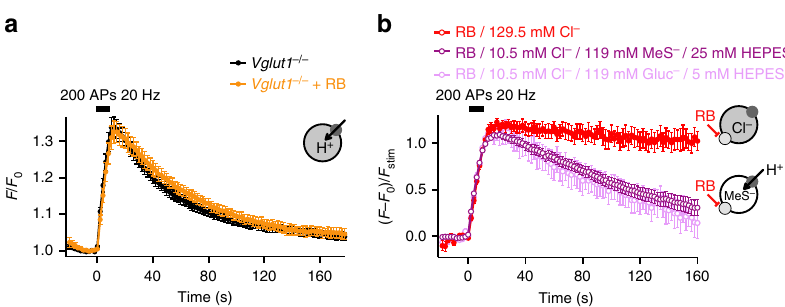
Fig. 2 VGLUT and V-ATPase are electrically coupled. a SpH fl uorescence time courses of glutamatergic boutons lacking VGLUT1 with ( n = 11) or without ( n = 22) RB. b SpH fl uorescence time courses upon stimulation (200 APs, 20 Hz) with RB and either normal Cl − concentration (129.5 mM) or a combination of 10.5 mM Cl − and 119 mM MeS − or Gluc − ( n = 13 and 18). Because of Gluc − buffering capacity, the HEPES concentration was reduced from 25 to 5 mM when Cl − was substituted with Gluc − (Fig. 5). Note that glutamatergic SVs are still sensitive to cytosolic pH changes as seen by the remaining transient post stimulus increase in SpH fl uorescence (Supplementary Fig. 4). The sketches illustrate H + movements. The dark grey and light grey circles symbolize V-ATPase and VGLUT, respectively. Error bars